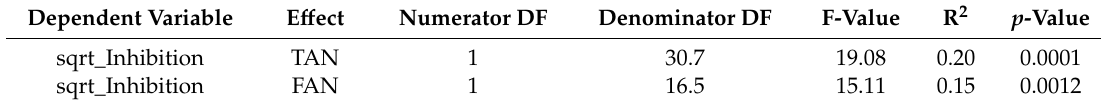
Table 5. The e ff ect of total ammonia nitrogen (TAN) and free ammonia nitrogen (FAN) on the inhibition in specific methane yield: the results of the fitted model. Degrees of freedom (DF). The square-root transformed values of inhibition in specific methane yield (sqrt_Inhibition); the transformation was done for meeting the requirements of the model.